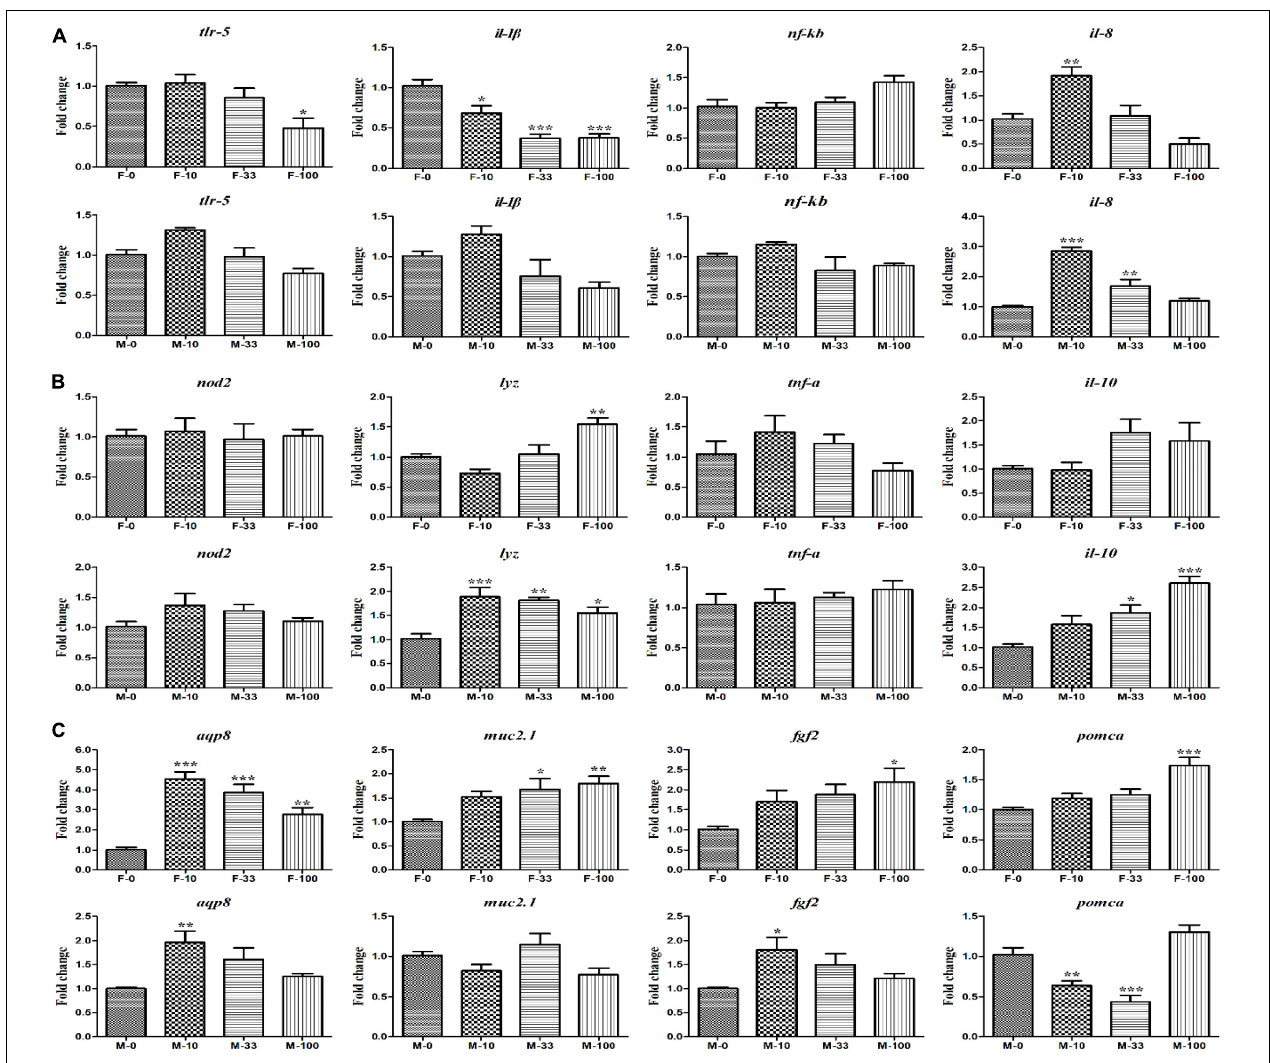
FIGURE 7 | The expression of the intestinal functions-related genes in DEHP exposed zebrafish intestines. (A) The relative expression of tlr-5 , il-1 β , nf- κ b , and il-8 genes involved in the immune response. (B) The expression of nod2 , lyz , tnf- α , and il-10 genes related to bacterial handling and antimicrobial defense. (C)